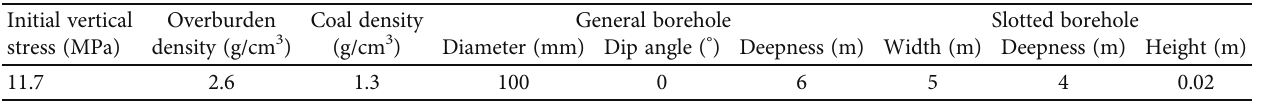
Figure 5: Sketch of depressurization induced by stress release. (a) Stress release by hydraulic slots method. (b) Segmented hydraulic slotting or cavity building along the directional wellbores. Table 4: The main conditions in the